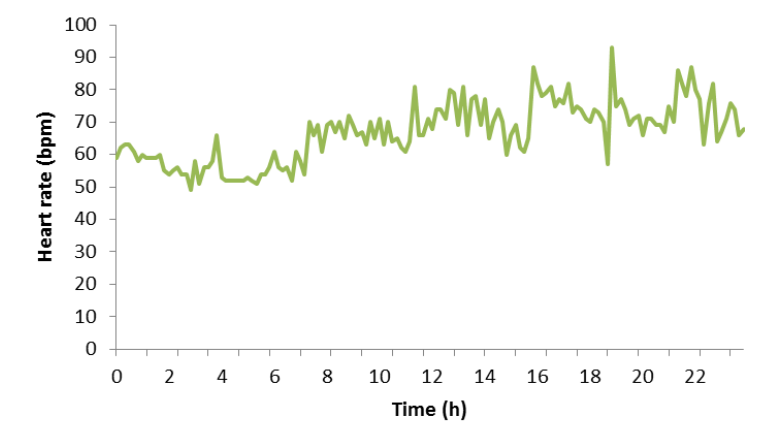
Figure 8. Heart rate in a normal day.